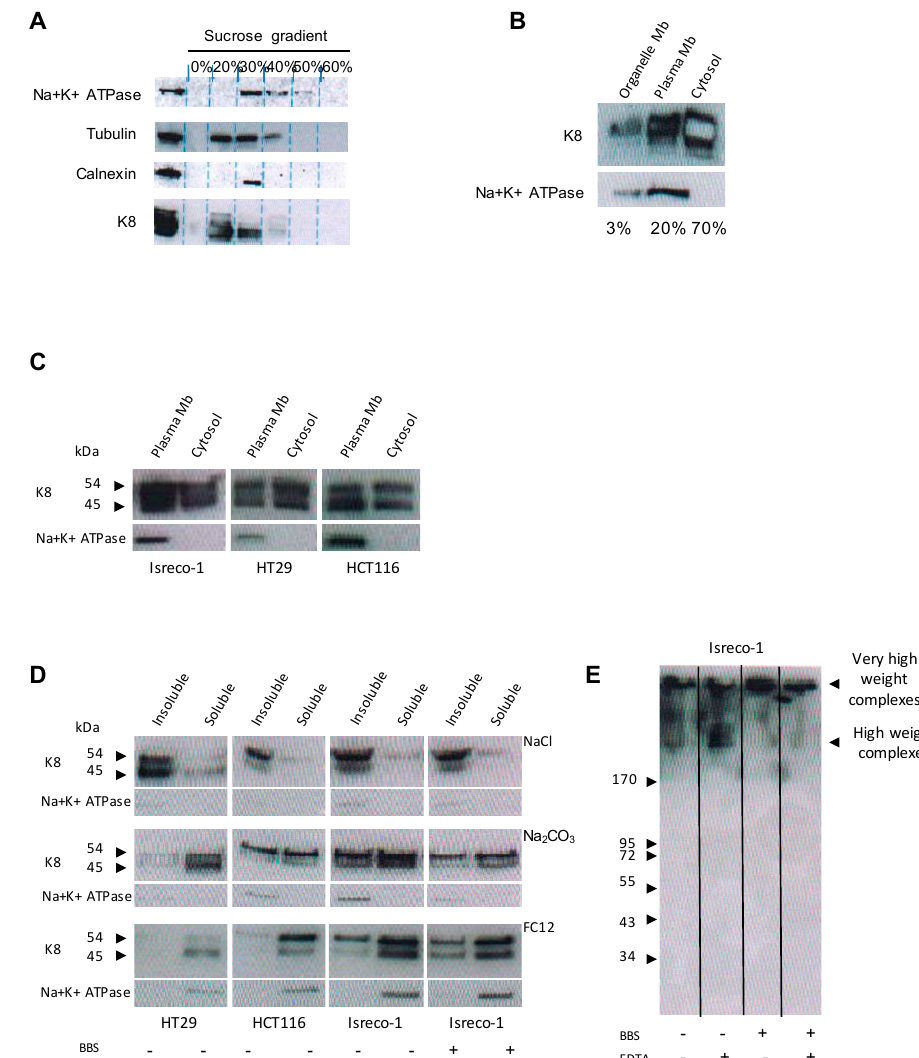
show that a fraction of K8 was anchored within the plasma membrane of CRC cells in high-molecular- weight complexes.